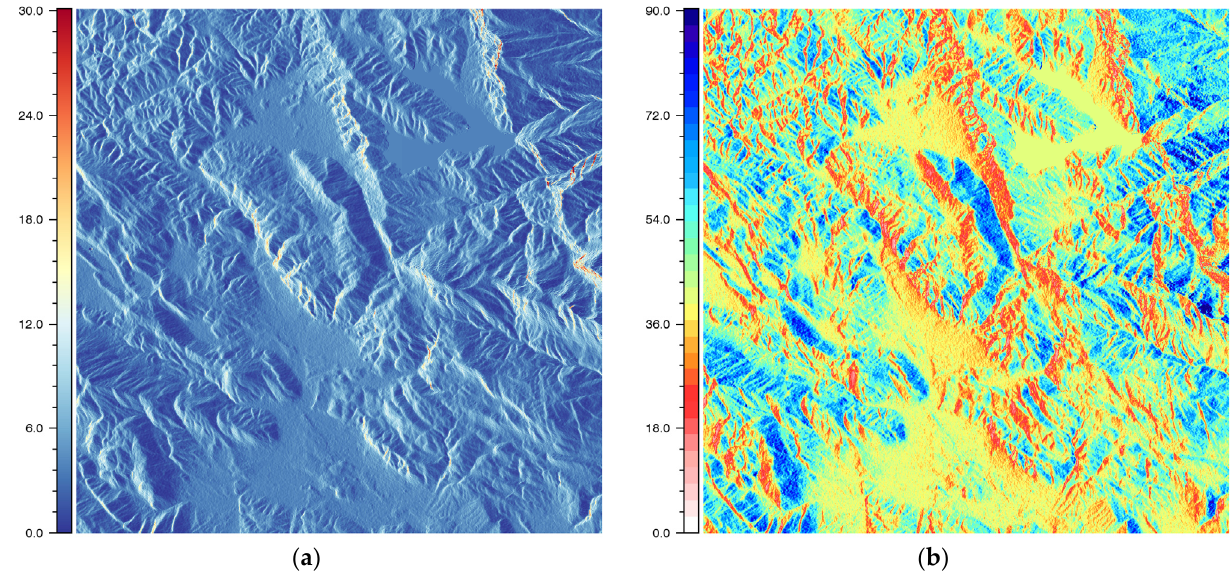
Figure 10. ( a ) Simulated radiometric-distortion image (dB) associated with the ground surface area; ( b ) local incidence angle (LIA) (degree): χ l = χ l ( r , a )